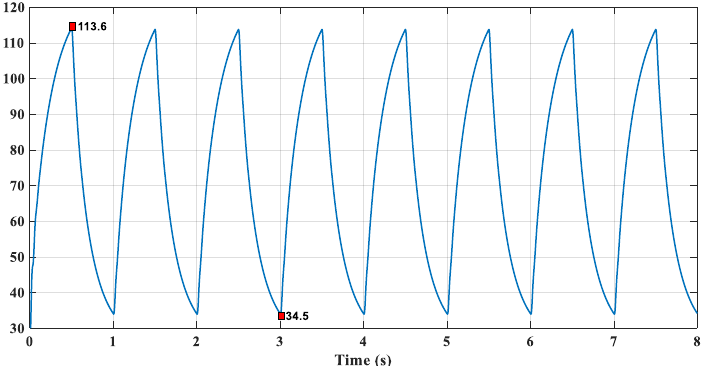
Figure 16. The temperature variations of the IGBT used in the boost converter during the power cycling test.